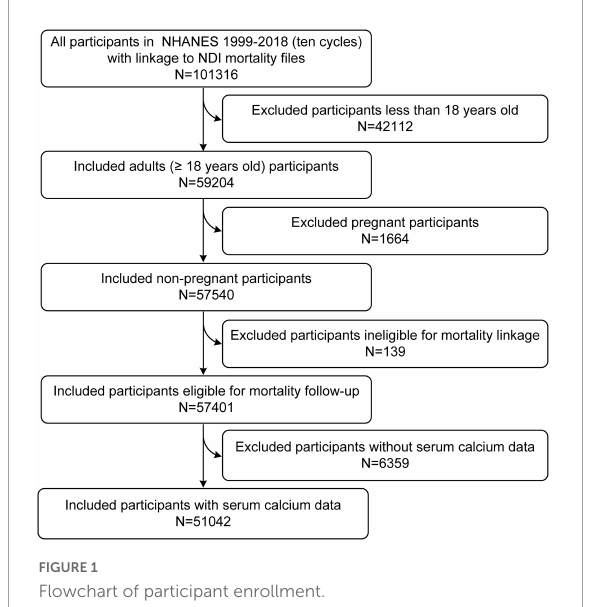
FIGURE1 Flowchart of participant